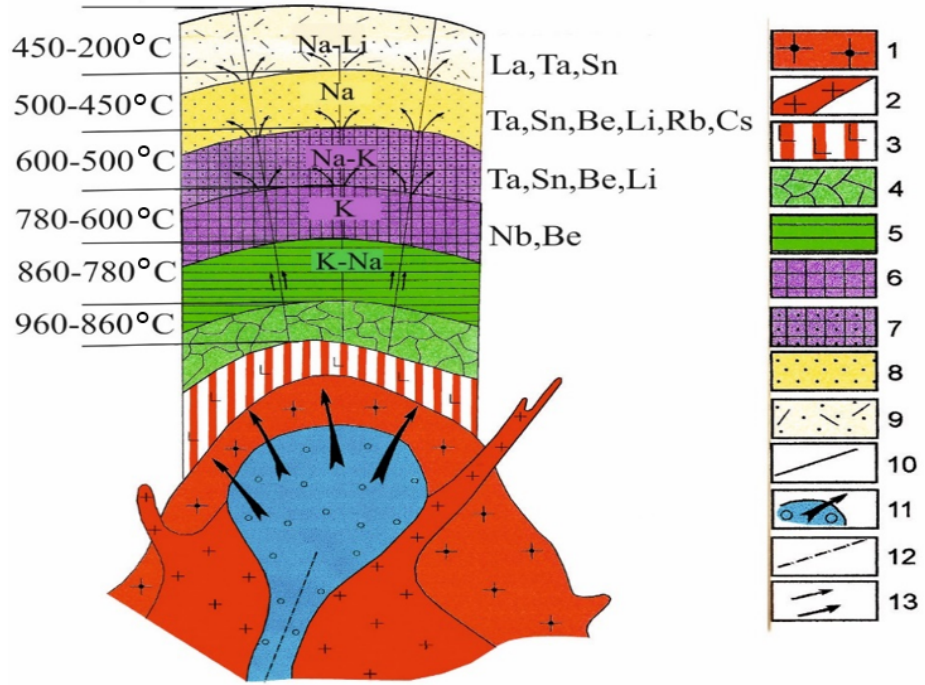
Figure 8. Formation model of Kalba rare-metal pegmatites. 1 = medium-coarse-grained biotite granites (phase I); 2 = fine- and medium-grained muscovite (phase II); 3 = aplite, aplitic granite; 4 = graphic pegmatite, 5 = oligoclase-microcline gangue pegmatite, 6 = microcline pegmatites (with beryl and columbite); 7 = microcline-albite pegmatite with tantalite, cassiterite, beryl, and spodumene; 8 = albitic pegmatite; 9 = albite-spodumene; 10 = fracture; 11 = direction of fluid flow; 12 = fault magma conduit; 13 = flow of ore-bearing melts